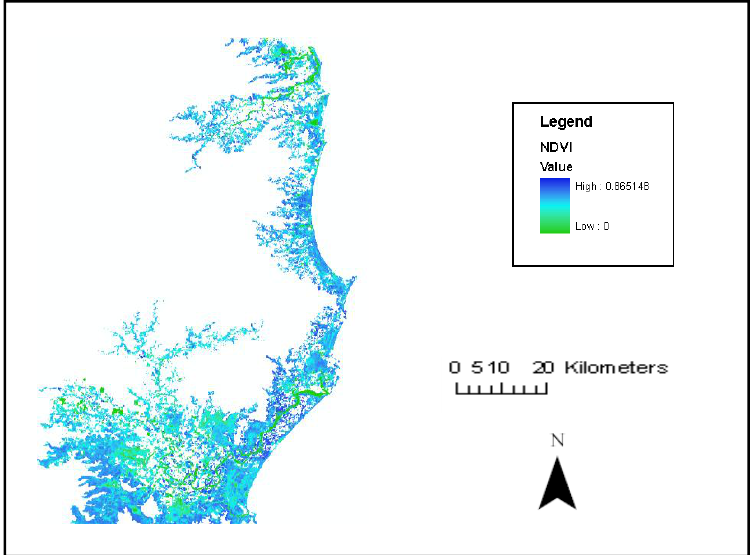
Figure 4. NDVI values of wetland vegetation in north-eastern NSW, Australia.